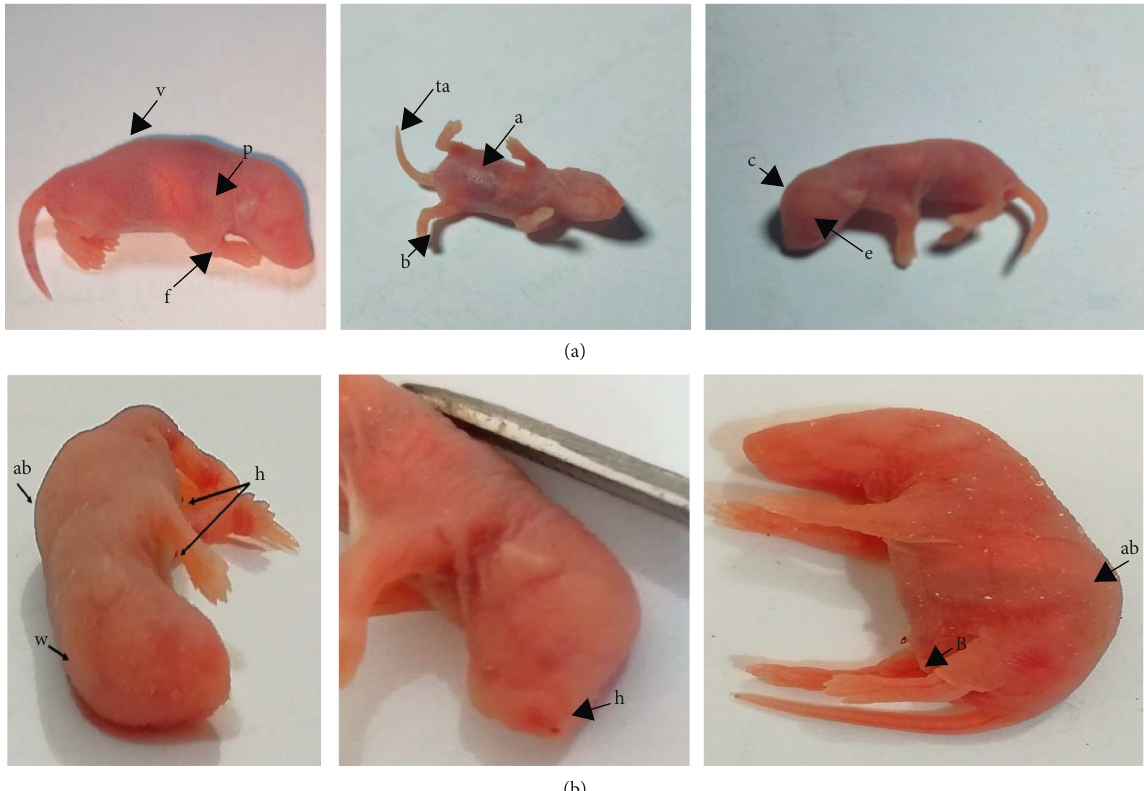
Figure 11: (a) The outward appearance of a normal newborn rat and (b) malformations in newborn mice resulting from the mating of male mice dosed with CuO NP at concentrations of 25 and 35mg/kg with healthy females. The deformities were represented by the appearance of (h) blood clotting (b) thickening of the skin and deformation of the hind limb, and (a, b) convexity of the column spine.